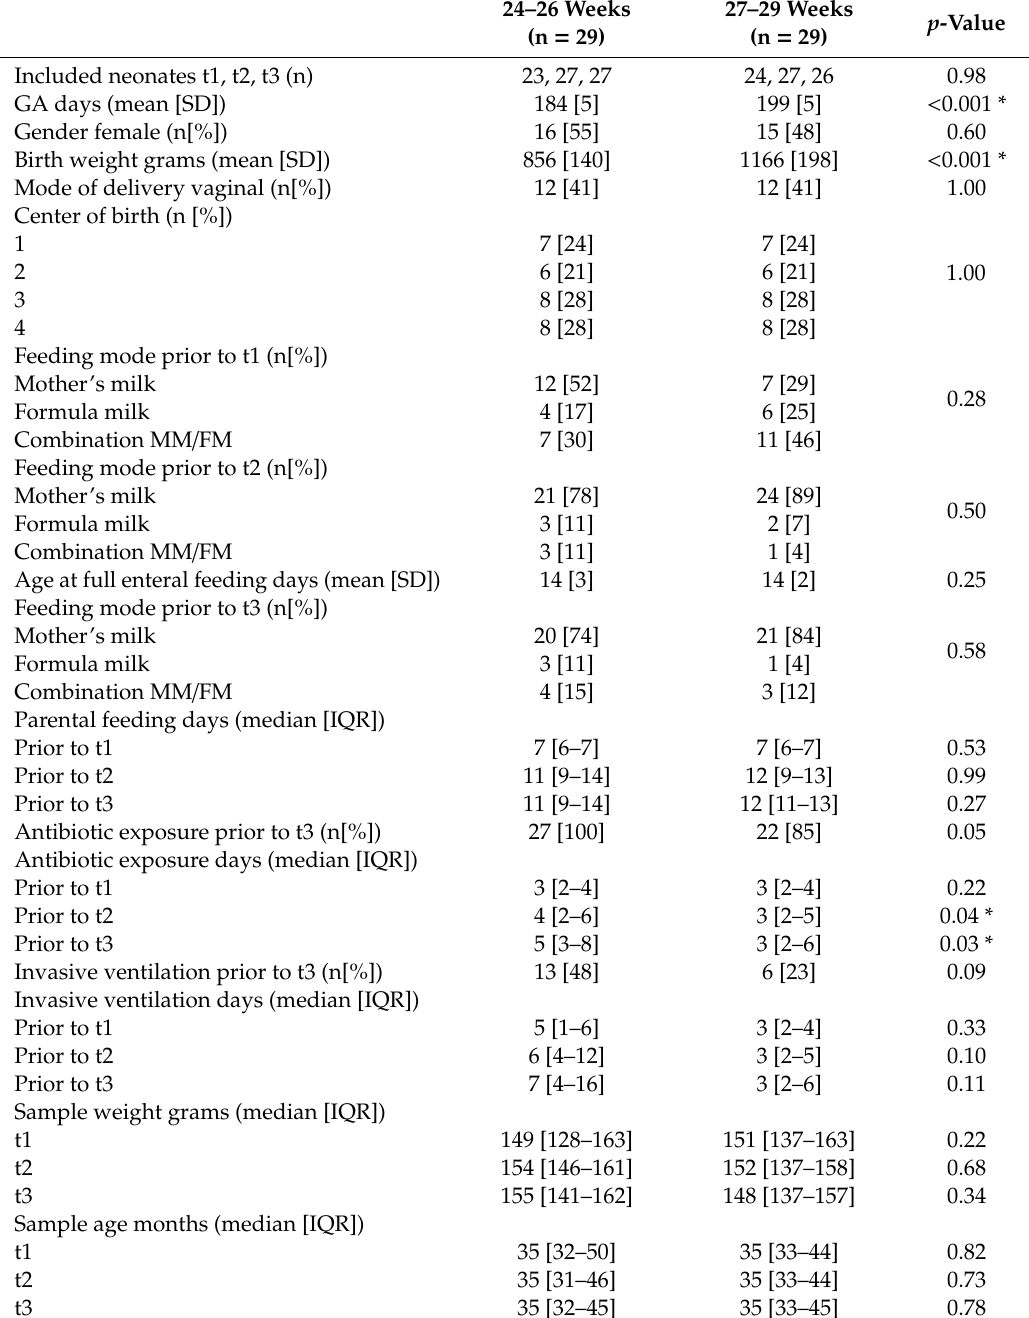
Table 1. Baseline characteristics for included neonates, based on gestational age